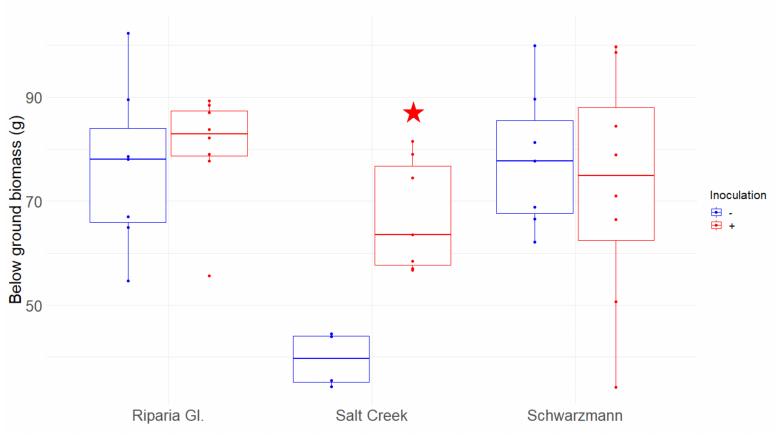
Figure 3. Below ground biomass (grams) of grapevine rootstocks after two years of field cultivation. Blue plots represent uninoculated while red plots represent inoculated rootstocks. Red stars above inoculated plots depict significant positive AM fungal response compared to uninoculated control. Statistical analysis was performed on the log